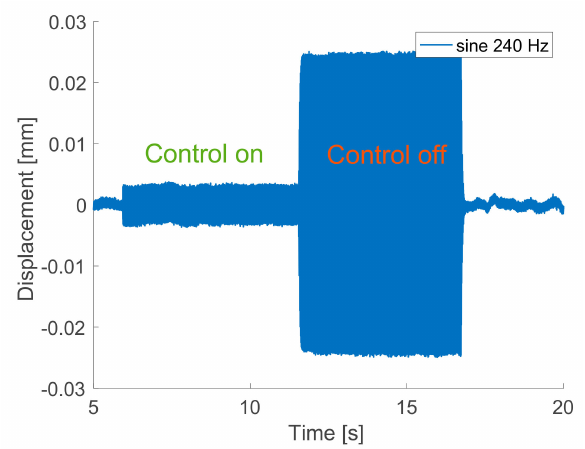
Figure 20. Measured displacement in case of control on and o ff in case of single frequency force